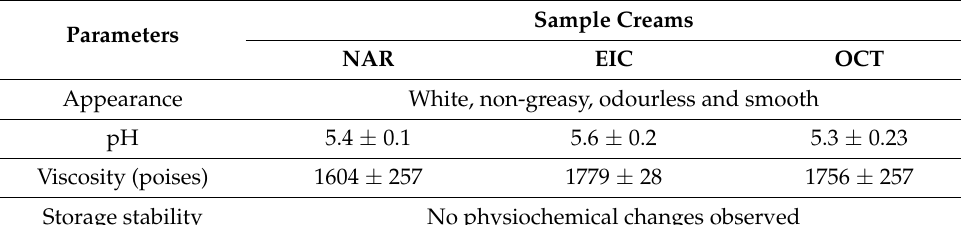
Table 2. Physiochemical evaluation of self-formulated sample creams.